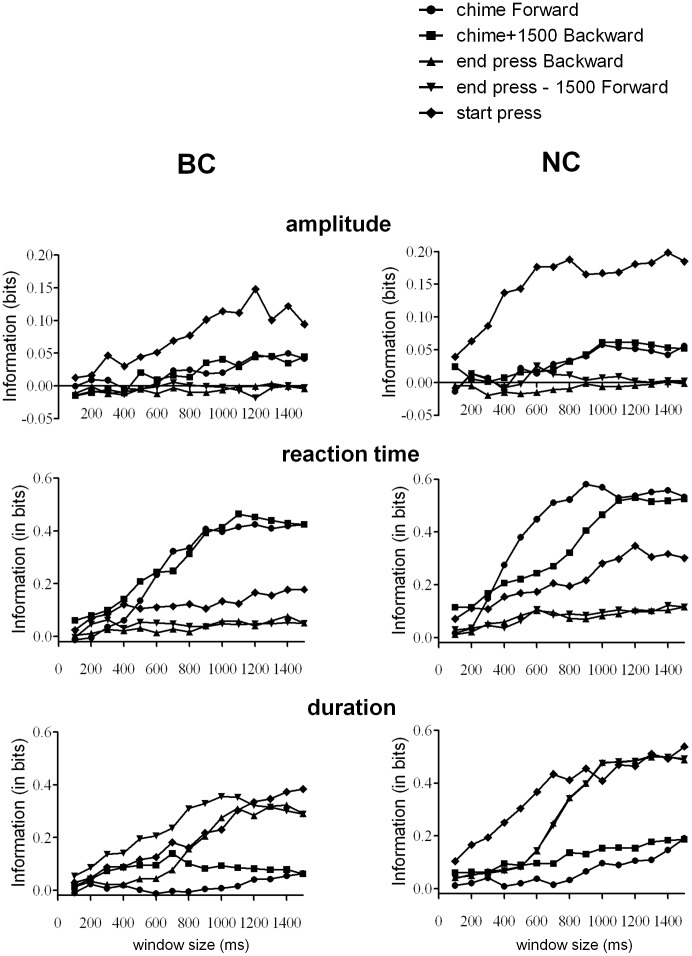
Information encoded by populations of neurons about the kinematics of hindlimb movement.The PETH based classification method was used to quantify the information encoded by simultaneously recorded neurons about each of the movement parameters in two modes of the experiment: BC (left panel) and NC (right panel). Starting from each event (chime, start-press or end press) the window size was incremented by 100 ms. The information is corrected by subtracting the value of the information obtained by shuffling the trials (bootstrapped, see methods). For events chime and end press the windows were incremented from the start and end of the previously used windows and incremented by 100 ms in the forward and backward direction respectively. For the start press event, the window was incremented by 100 ms around the event. The y axis represents the information value in bits, averaged across all recording days. The x axis represents the size of the time window in milliseconds.